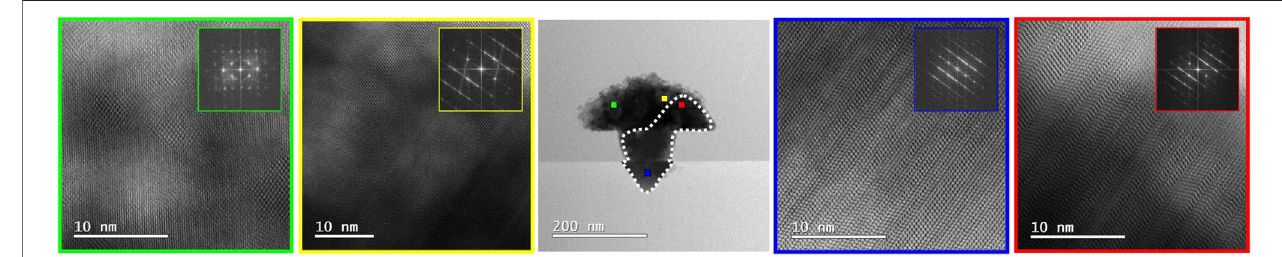
FIGURE 7 | (S)TEM analysis of the melted and crystallized InSb structure. The region with an epitaxial relationship to the substrate is marked with the white dotted line. BF HR-(S)TEM images marked with red and blue show the zinc blend monocrystalline region of the InSb structure. The remaining part of the structure is nano crystalline and marked with yellow and